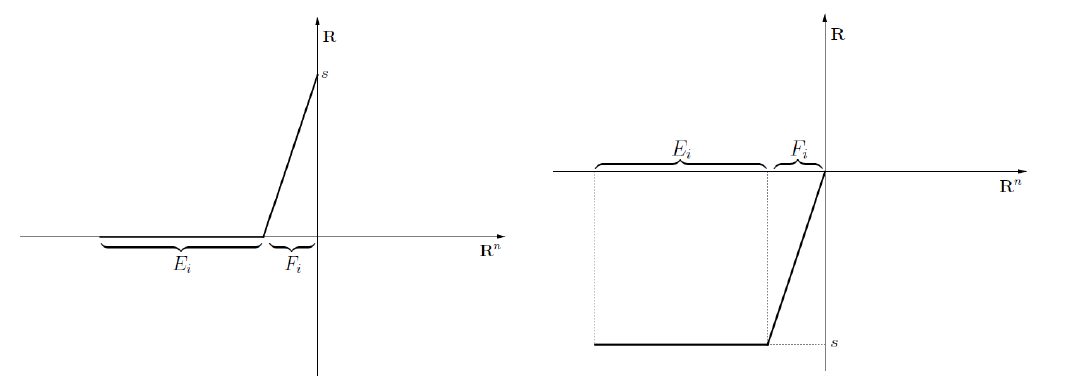
Figure 3: The construction of v i for s > 0 and s <